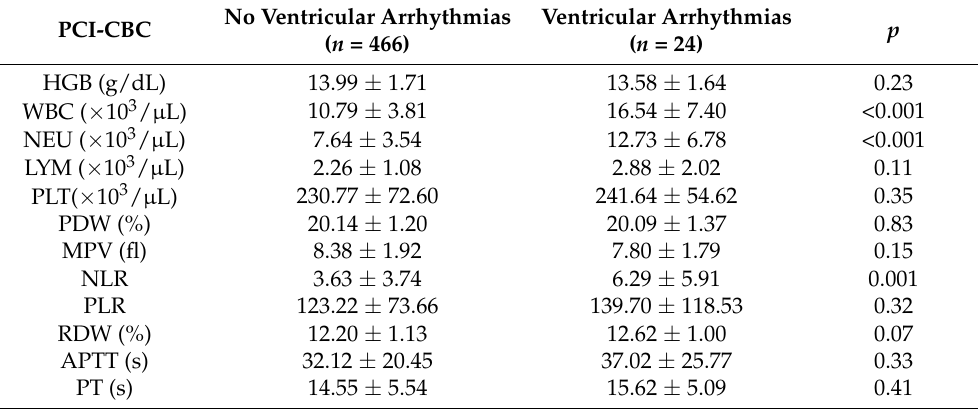
Table 10. Hematological and coagulation parameters of the groups with/without ventricular rhythm disturbances in PCI treated patients.